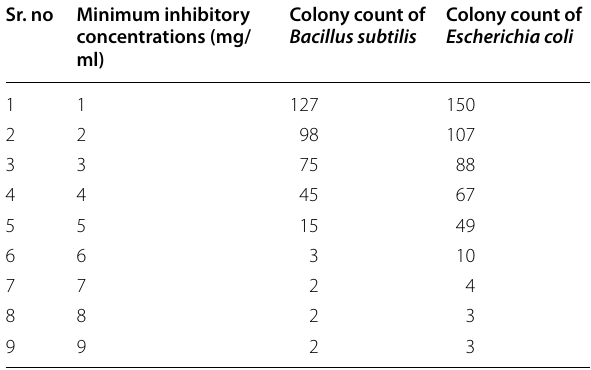
Table 2 Minimum inhibitory concentration of biosynthesized copper nanoparticles against Bacillus subtilis and Escherichia coli